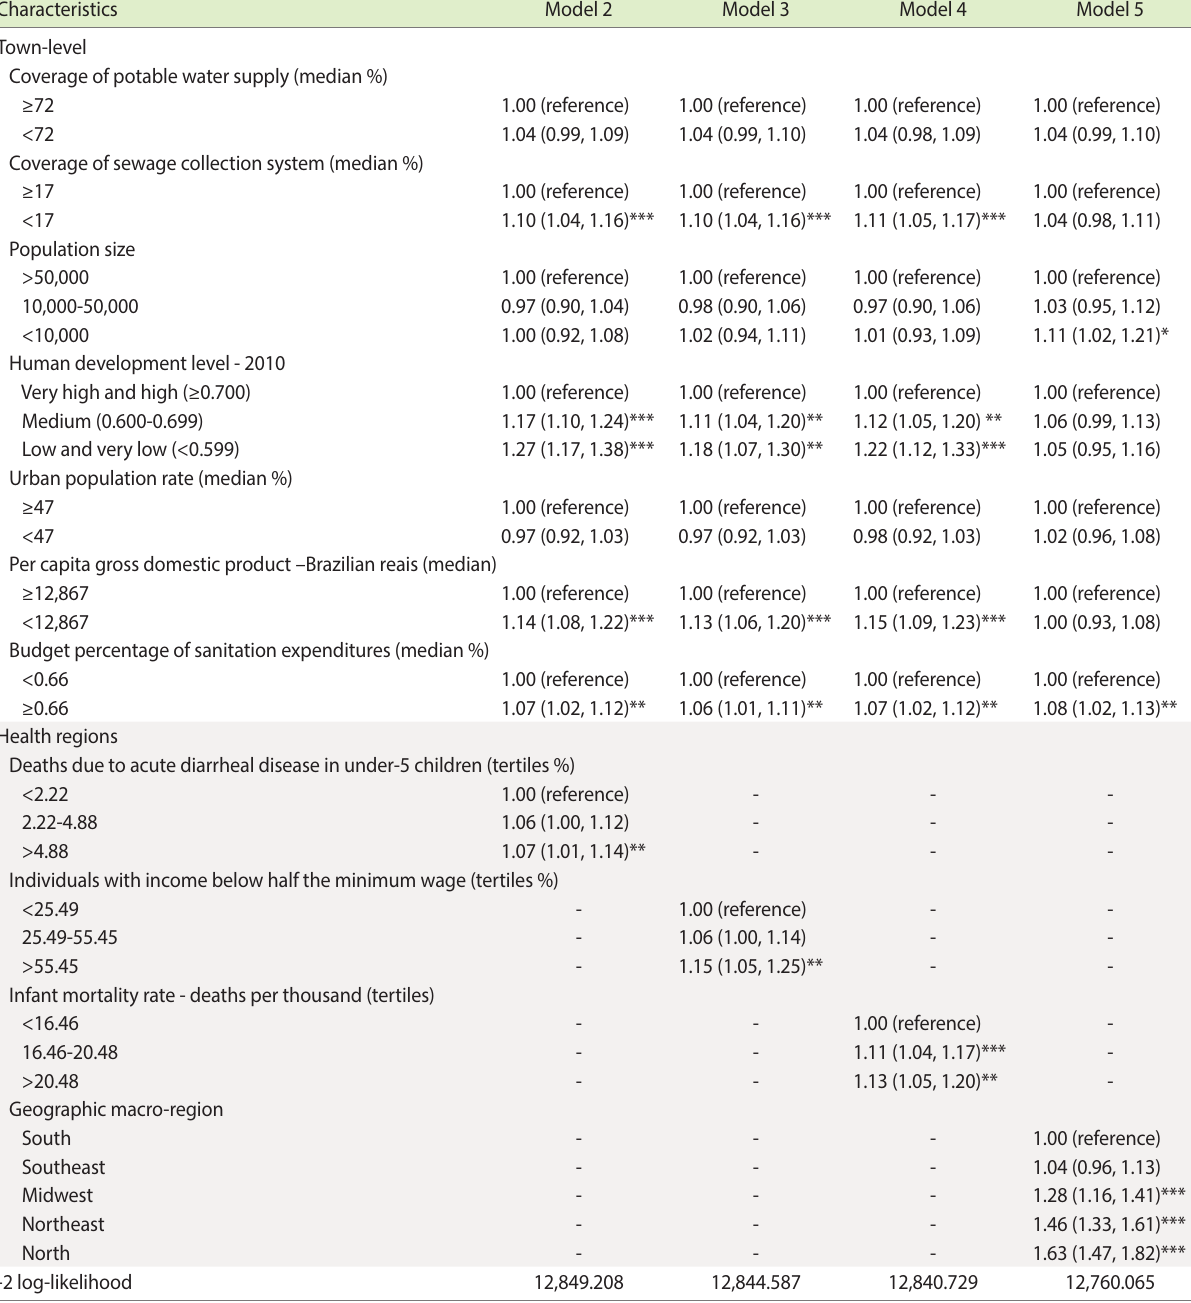
Table 3. Adjusted values of associations between the lack of water fluoridation provision and municipality and health region-level charac- teristics in Brazil, 2008